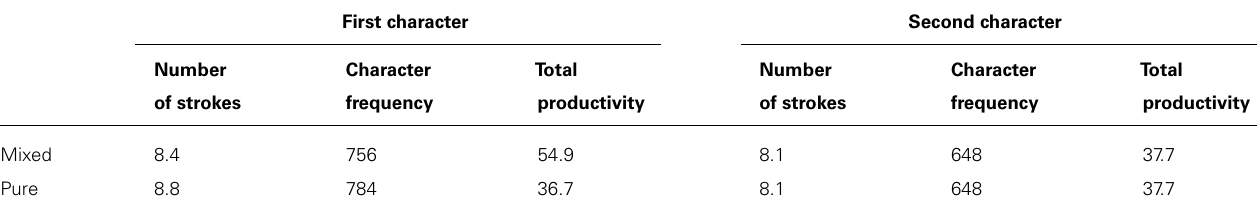
Table 2 | Properties of stimuli.